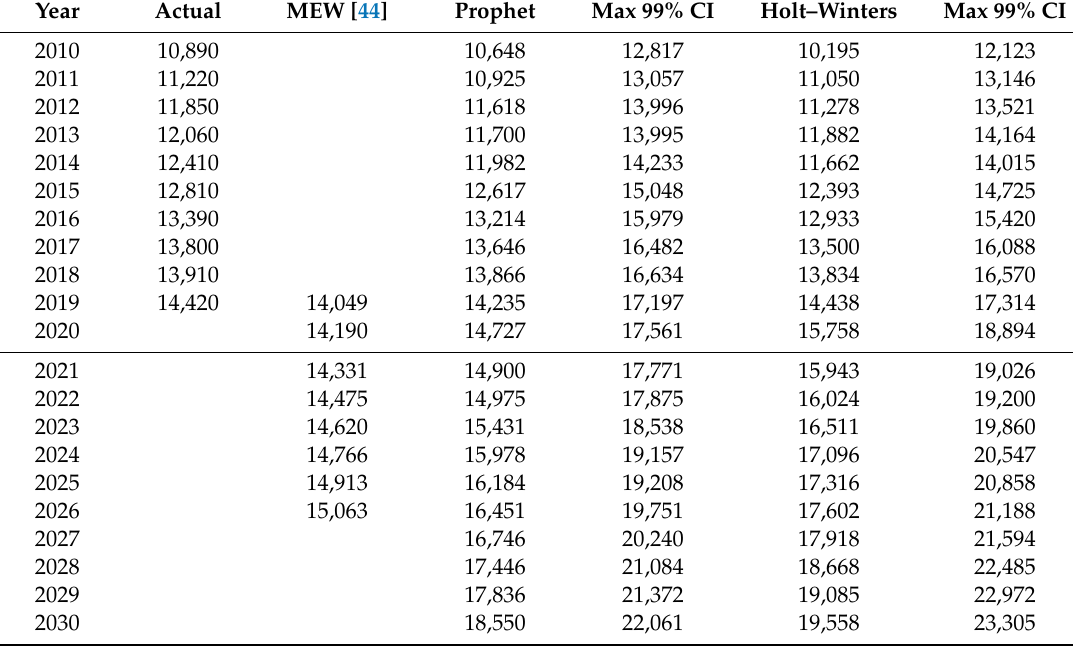
Table 3. Comparison between the maximum load of actual data, forecasted maximum peaks from Ministry of Electricity and Water and the Prophet and Holt–Winters models.